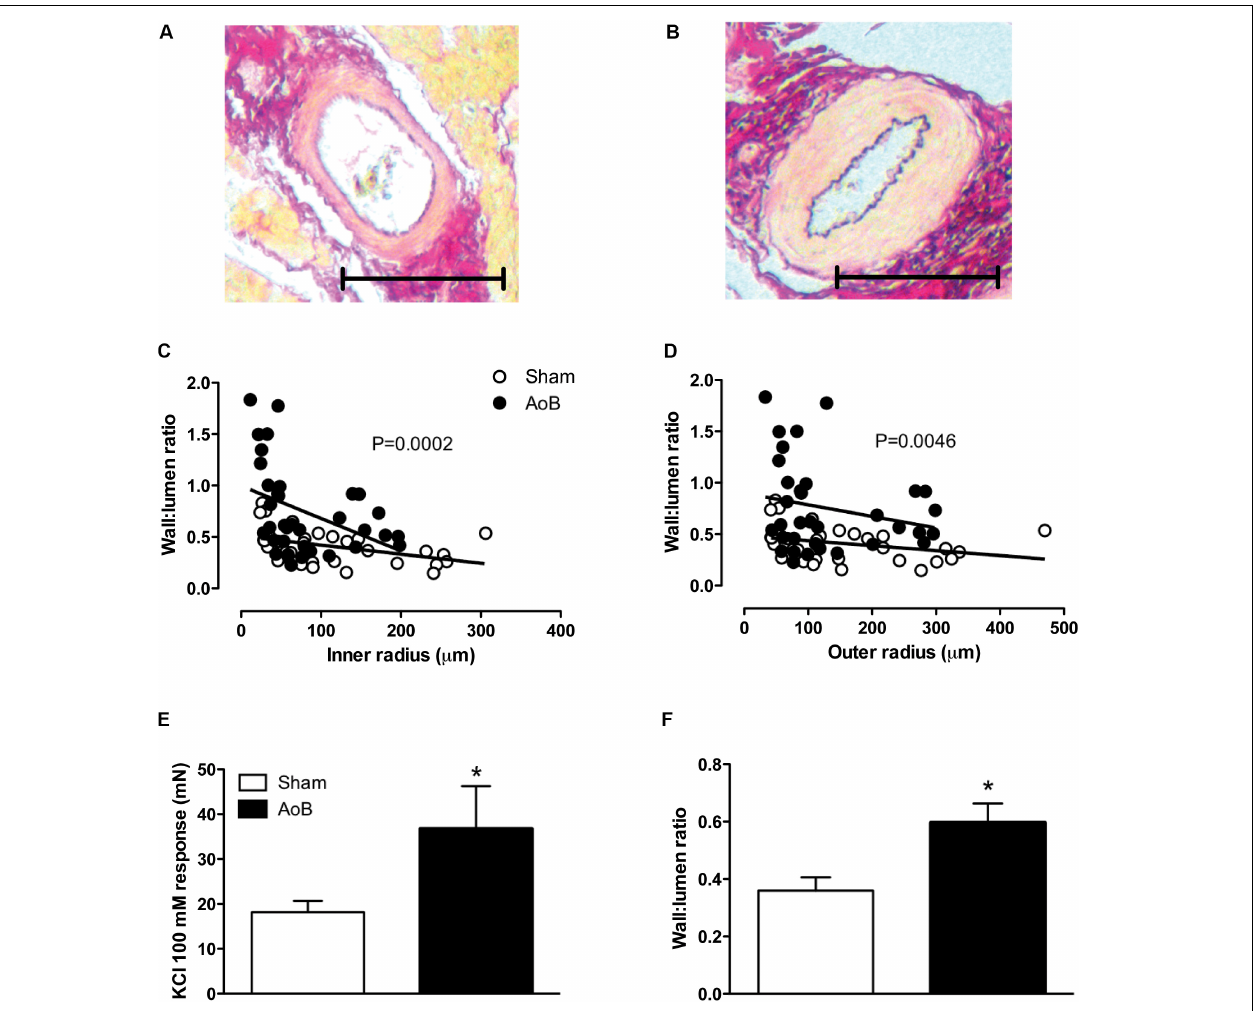
FIGURE 1 | Typical examples of coronary small arteries within the myocardium of Sham-operated swine (A) and swine with AoB (B) . The scale bar denotes 100 µ m. The wall to lumen ratio both as a function of inner (C) and outer (D) was significantly increased in myocardium from swine with AoB. Shown are 34 vessels from 4 Sham-operated swine and 36 vessels from 5 AoB swine. The vasoconstrictor response to 100 mM KCl was significantly increased in vessels from AoB ( n = 6) as compared to Sham ( n = 8), (E) . The wall to lumen ratio in vessels with inner diameters ranging from 100 to 200 µ m was increased in AoB as compared to Sham (F) . ∗ P < 0.05 AoB vs.